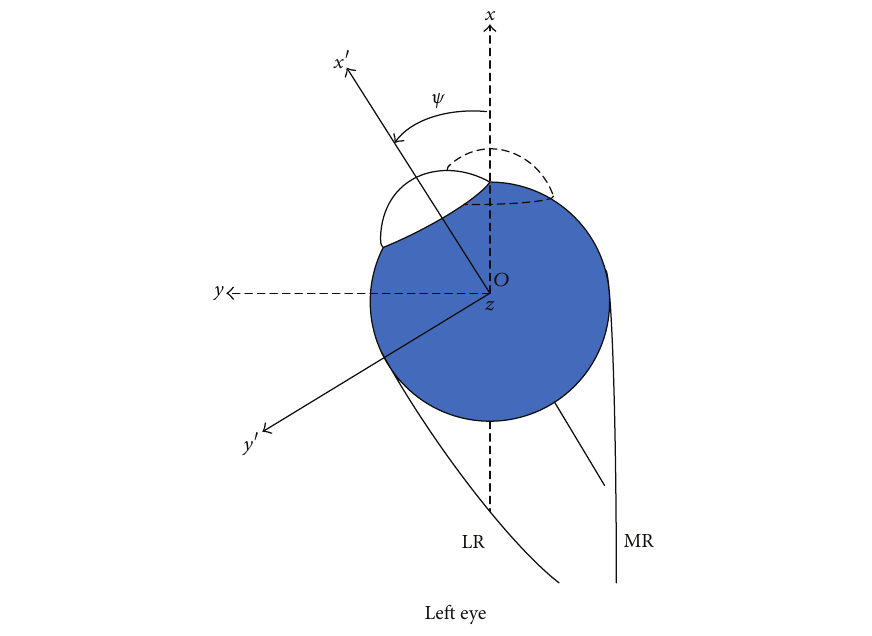
Figure 1: Schematic of horizontal movement of the left eye, in which only the lateral rectus (LR) and the medial rectus (MR) are plotted. 𝑥(𝑥,𝑦,𝑧) is the reference configuration, and 𝑥 󸀠 (𝑥 󸀠 , 𝑦 󸀠 ,𝑧) is the current configuration after the eye rotating by 𝜓